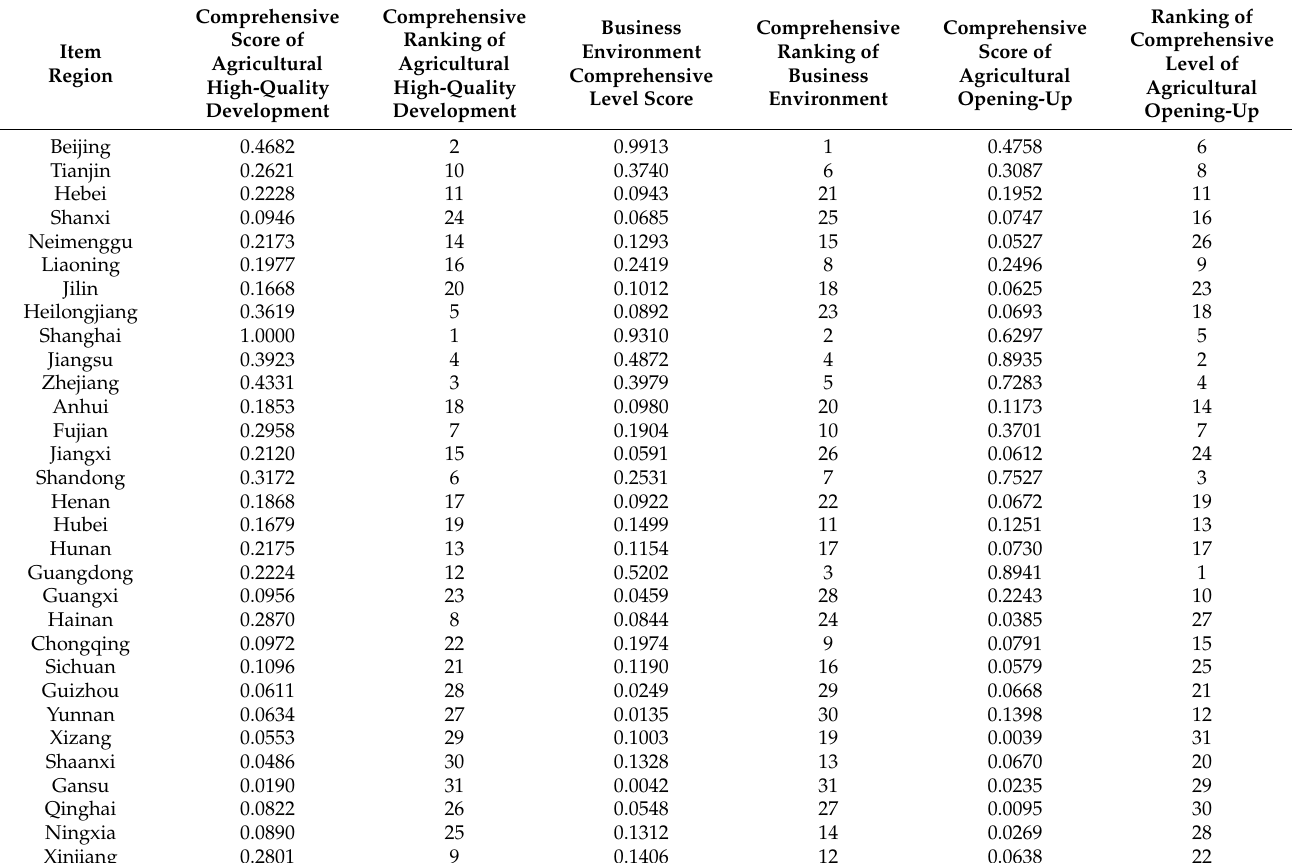
Table 4. Scores and rankings of high-quality agricultural development, business environment and agricultural opening-up in various